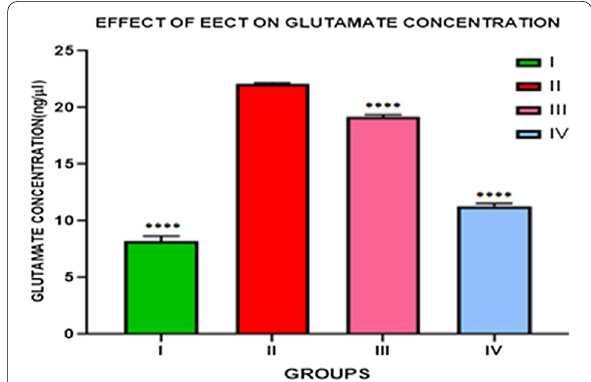
Fig. 6 Effect of EECT on glutamate